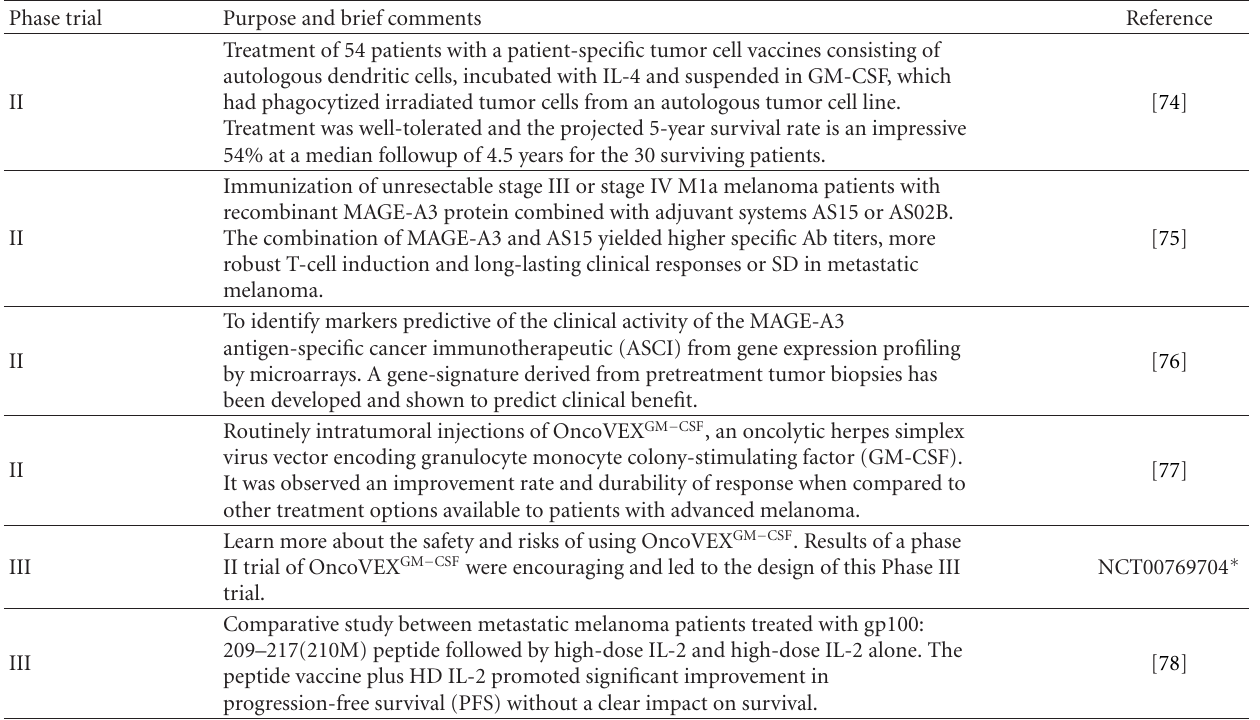
Table 4: Recent report vaccine approaches to advanced malignant